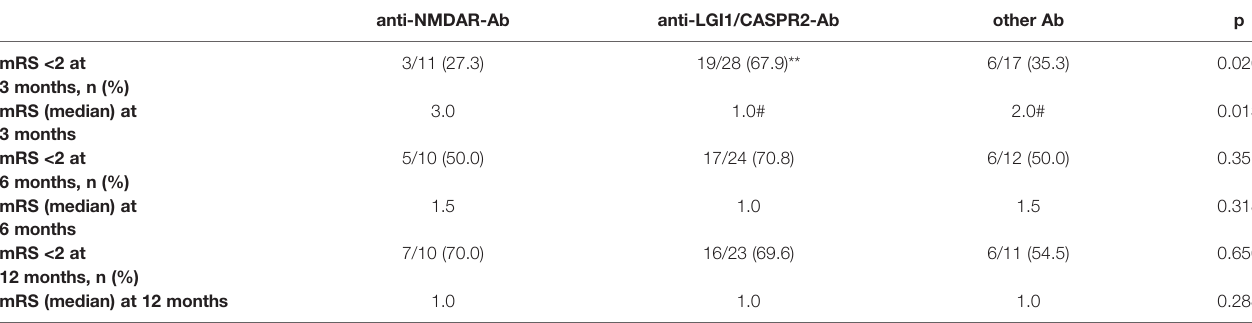
TABLE 3 | Functional outcome at 3, 6 and 12 months of follow-up in patients at the time of data extraction for this study. anti-NMDAR-Ab